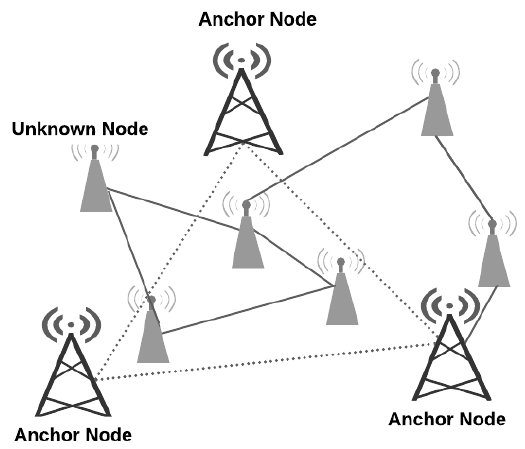
Figure 7. Hop count scenario.